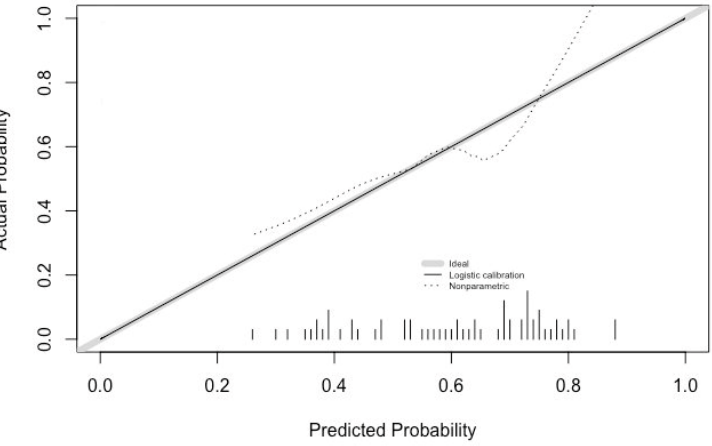
Figure 3. Calibration analysis.